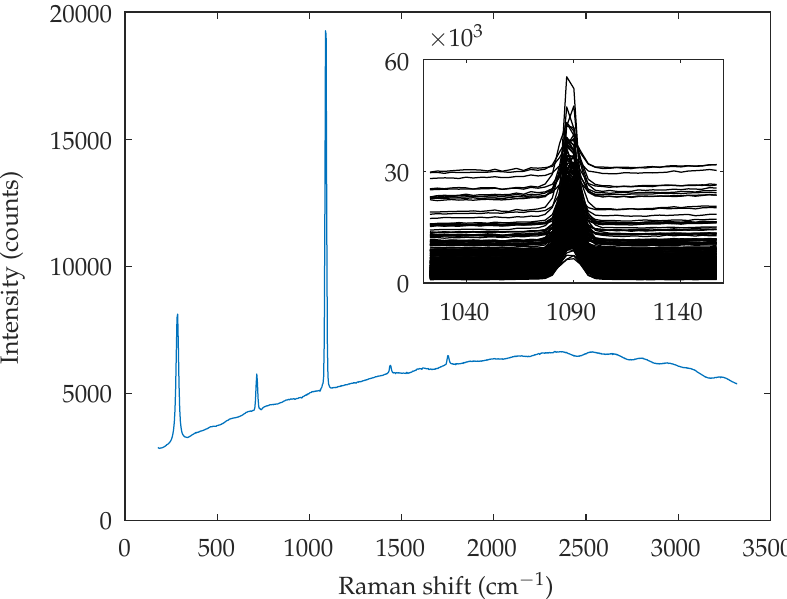
Figure 5. Average Raman spectrum of the control dataset from the marble sample. All 441 acquisitions showed the band at 1087 cm − 1 and they are displayed in the